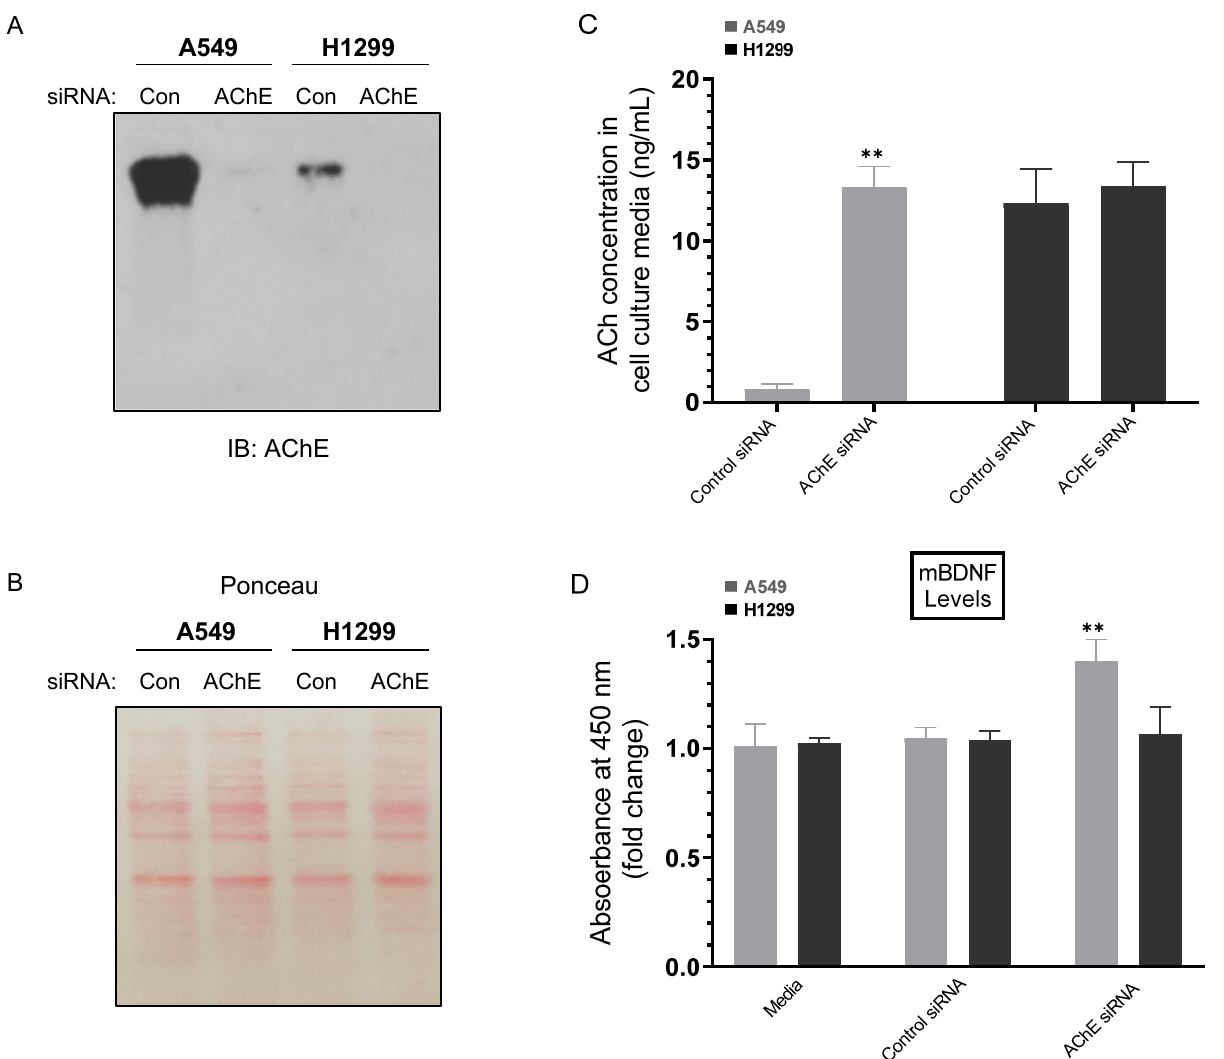
Figure 3. Treatment of cells with AChE siRNA resulted in higher levels of ACh and mBDNF in A549 cell media compared to control siRNA. Cells (0.2 × 10 5 ) were grown in 10% FBS-supplemented media for 24 h. The following day, the cell monolayers were incubated in serum-free media for 24 h, then treated for 72 h with the indicated siRNAs as described in the Methods section. The same concentration of total protein (15 µ L of 600 µ g/mL) of the media ( A ) was used for Western blotting using the indicated antibody (IB: AChE). Total protein (Ponceau staining) ( B ) served as a loading control. The same amount of protein (3 µ L of 600 µ g/mL total protein) of the media was used to quantitate the levels of ACh ( C ) and mBDNF ( D ) (Methods). Data from five independent assays, each carried out in triplicate, were averaged ( C , D ), normalized and expressed as fold change ( D ) relative to cells transfected with control siRNA using the GraphPad 9.4.1 software. The graphs summarize the results expressed as means ± SD (n = 5). Asterisks indicate a statistically significant difference from the corresponding samples transfected with control siRNA, ** p < 0.01 of each cell line. Absence of asterisks indicates no significance, Mann–Whitney